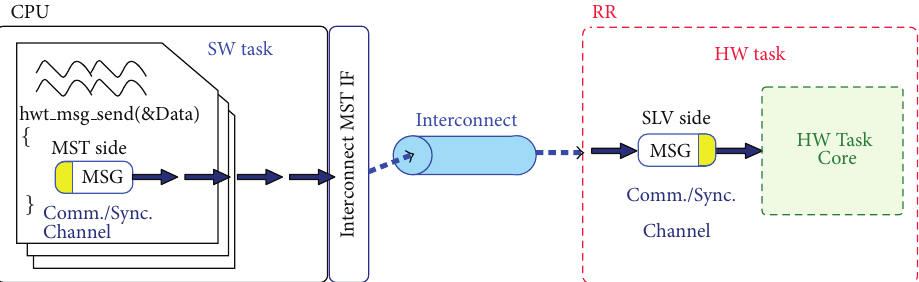
Figure 17: SW-HW channel-based communication.